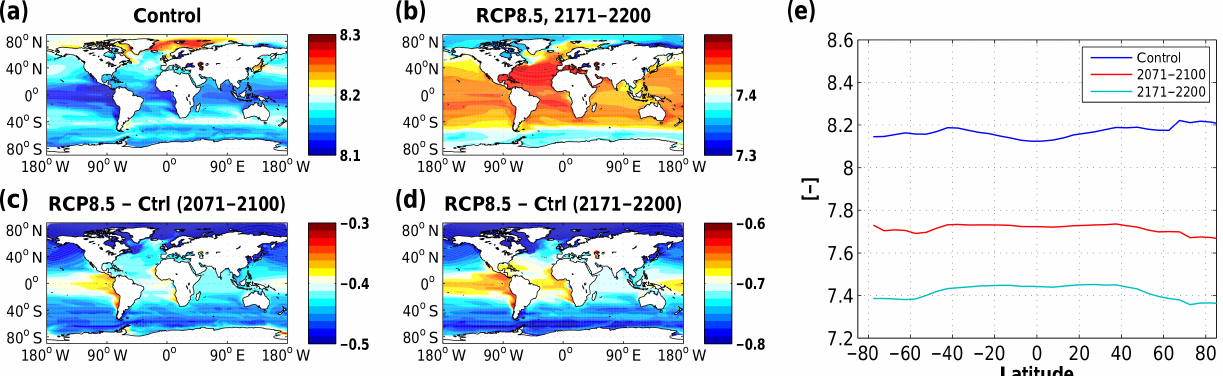
Figure 4. Surface ocean pH (a) in the control simulation, (b) in the RCP8.5 scenario simulation BASE (very similar for SMED and SHIGH) towards the end of the 22nd century (2171 to 2200), (c) change found in the RCP8.5 scenario simulation BASE relative to the control run towards the end of the 21st century (2071 to 2100), and (d) same as (c) but towards the end of the 22nd century (2171 to 2200). Panel (e) displays the zonal means of pH in the control run (dark blue) and for the RCP8.5 scenario BASE (red, light